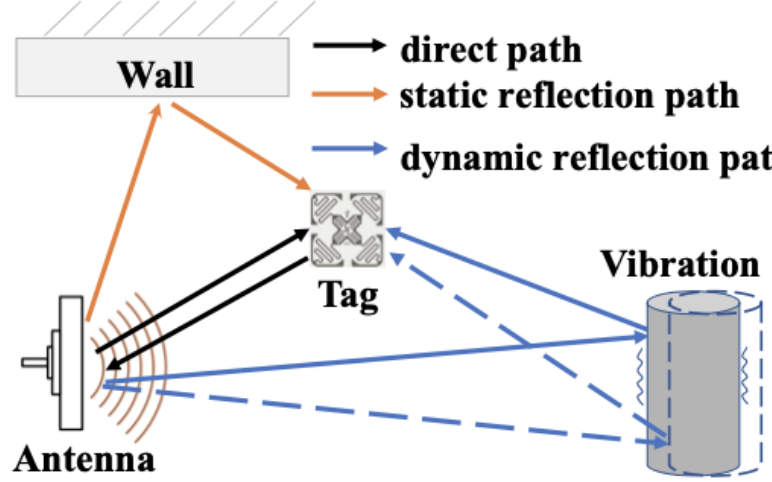
Figure 4. Vibration model